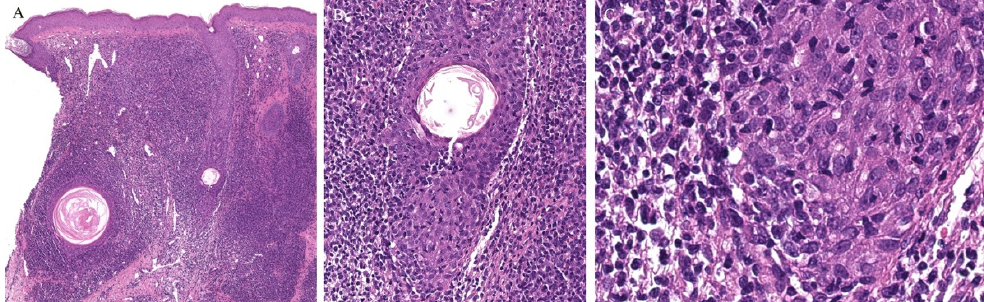
Figure 10. ( A – C ) Histopathology of follicular mycosis fungoides.